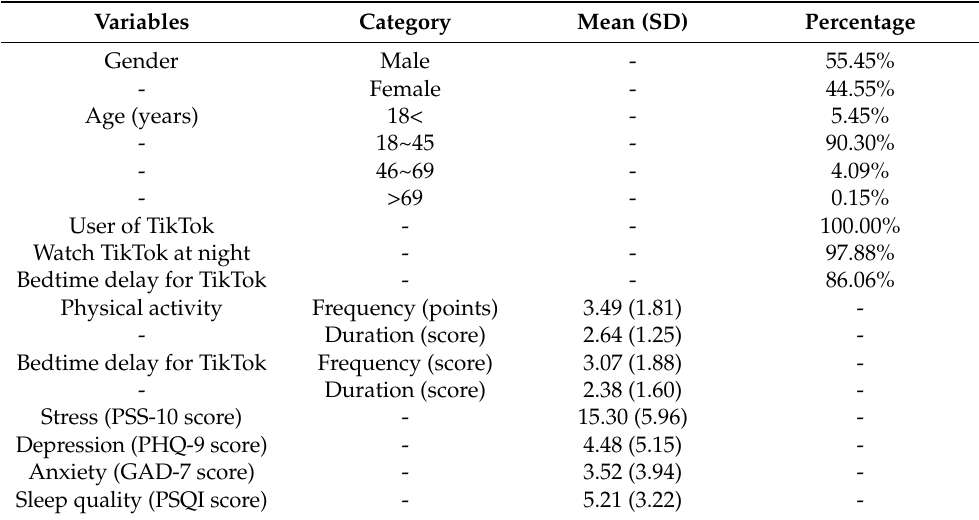
Table 2. Summary statistics of the study population.